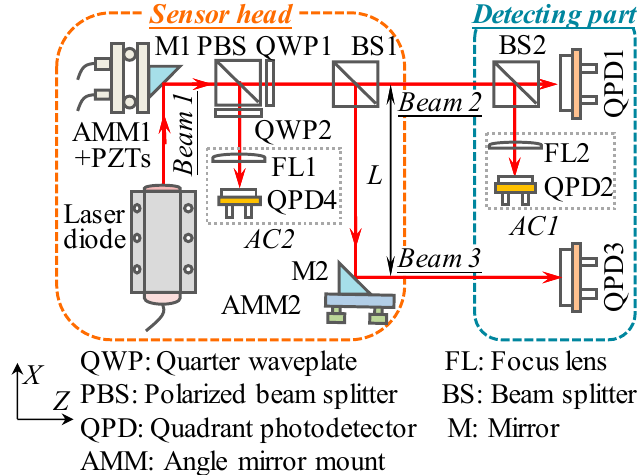
Figure 1. A schematic of the optical configuration for the five-degree-of-freedom (five-DOF) laser measurement system.